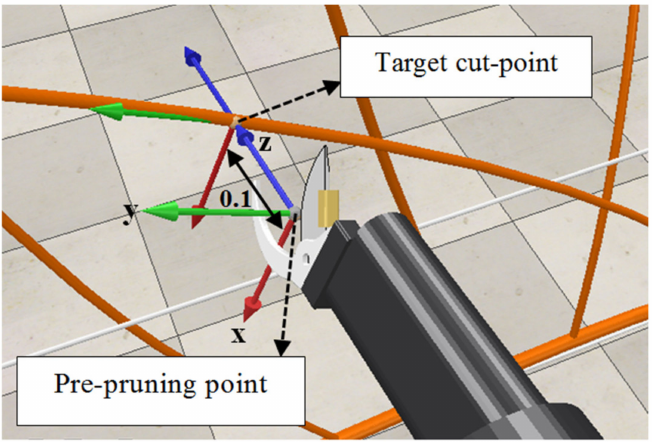
Figure 13. The end-effector at the pre-pruning point (Lengths are in